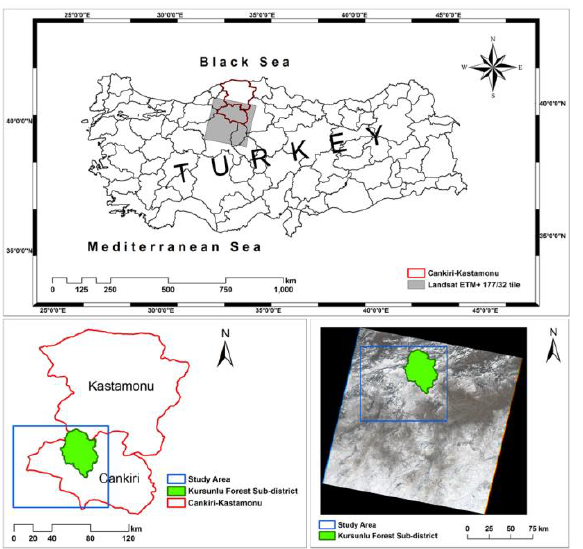
Figure 1: Study area.